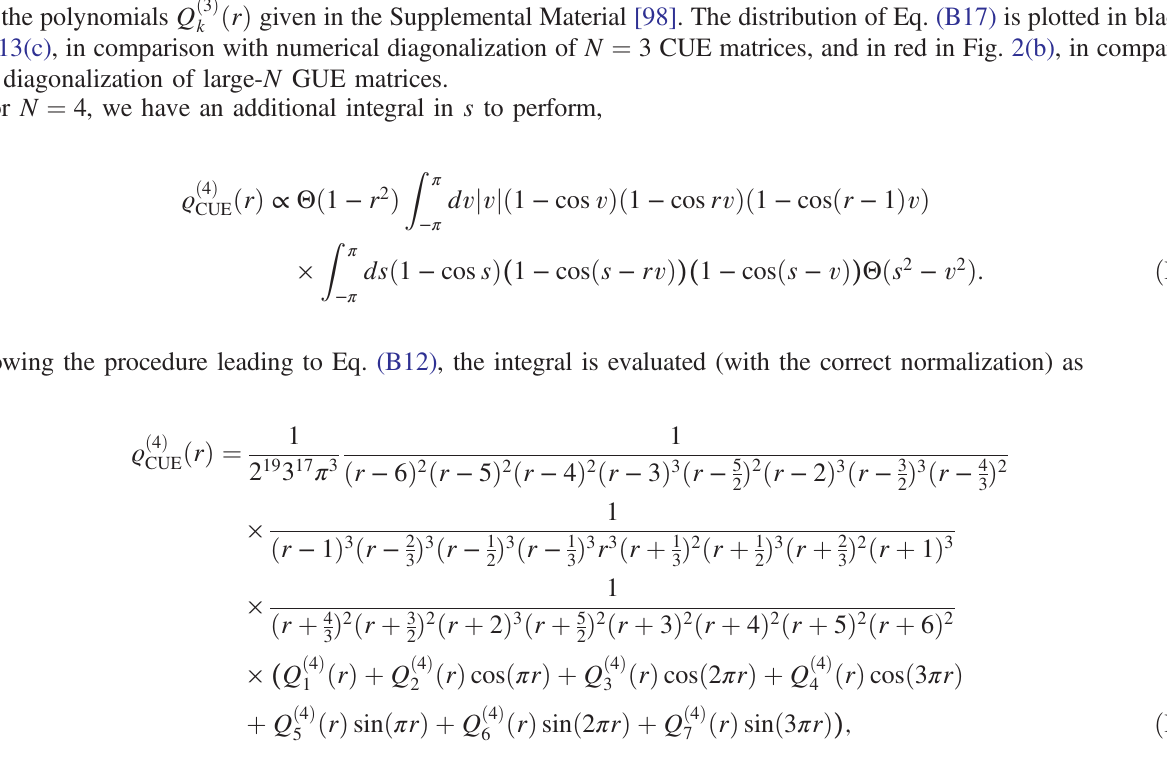
Fig. 13(d), in comparison with numerical diagonalization of N ¼ 4 CUE matrices, and in blue in Fig. 2(b), in comparison with exact diagonalization of large- N GUE matrices. Although in the large- N limit we can give only approximate expressions for the complex spacing ratio distribution, the small-size surmises computed for the circular ensembles describe very well the universal large- N asymptotics. Indeed, the distribution for the N ¼ 4 CUE is already indistinguishable (to the naked eye) from the numerical N → ∞